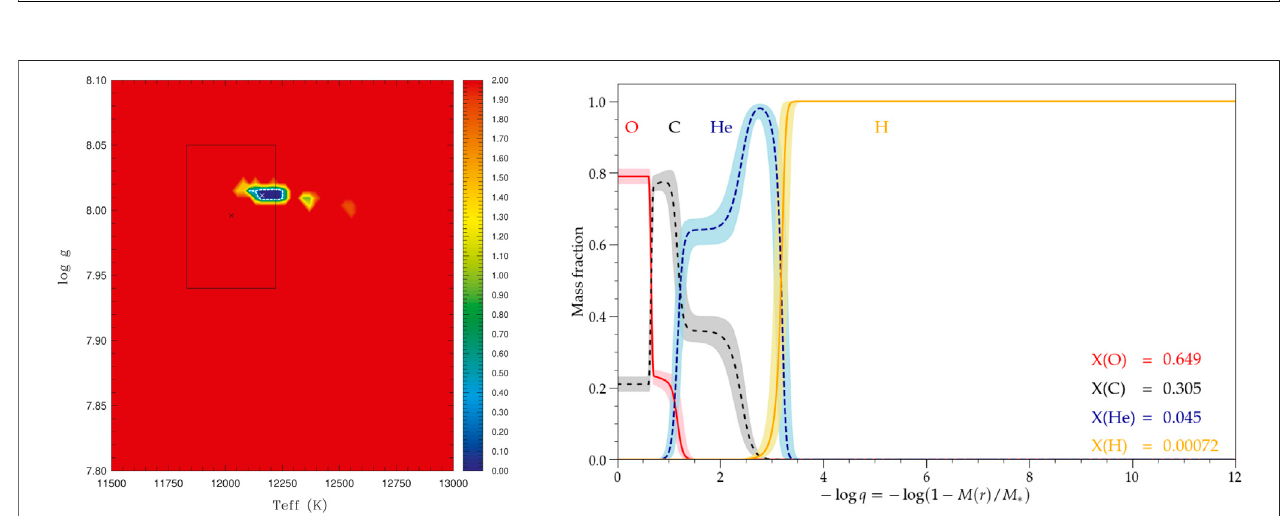
FIGURE 6 | Same as Figure 5 , but for the star KIC